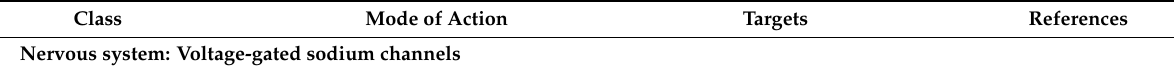
Table 2. Plant-based natural products with pesticide activity.